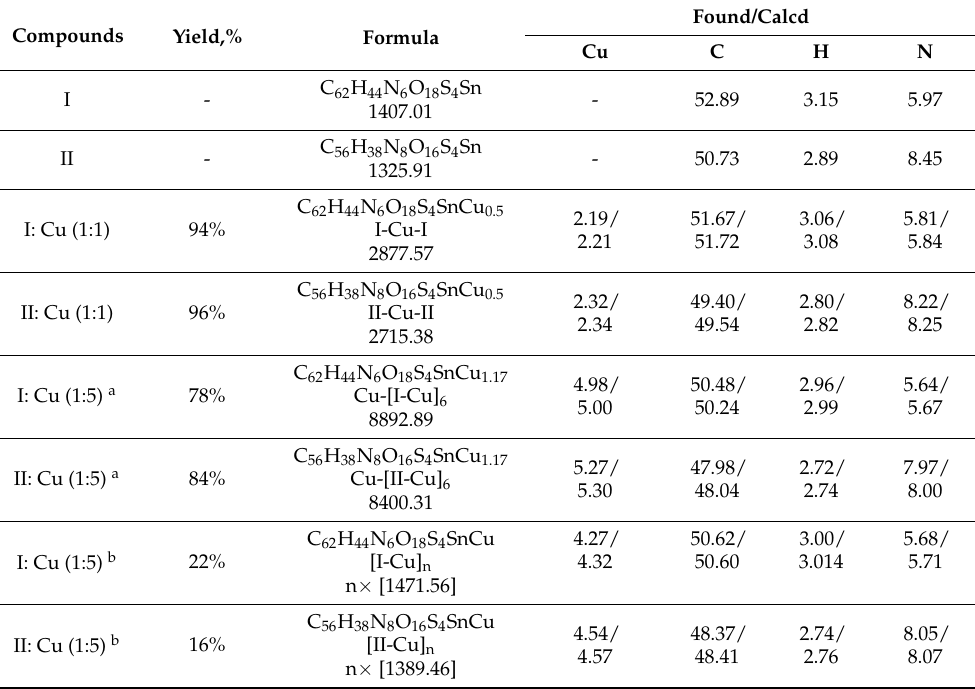
Table 2. Empirical formula, molecular weight, and elemental analysis data of the reaction (1) products with the ratio of reagents (1:1 and 1:5).